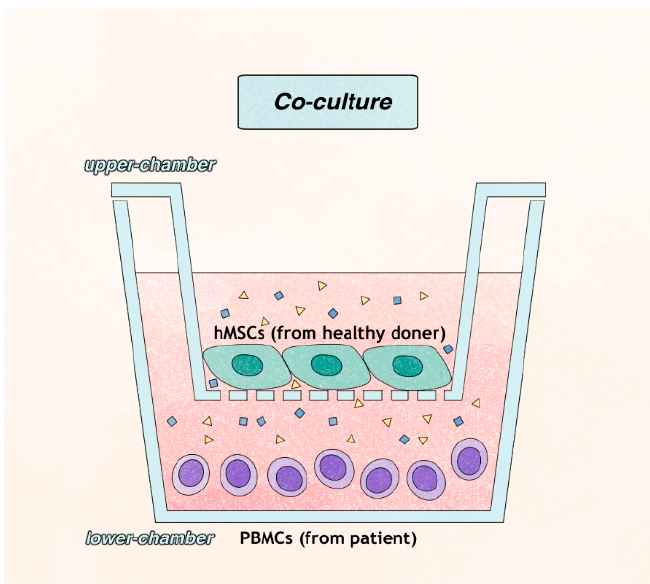
Figure 6. Ex vivo model for assessing the effects of hMSC treatment on hPBMC culture.